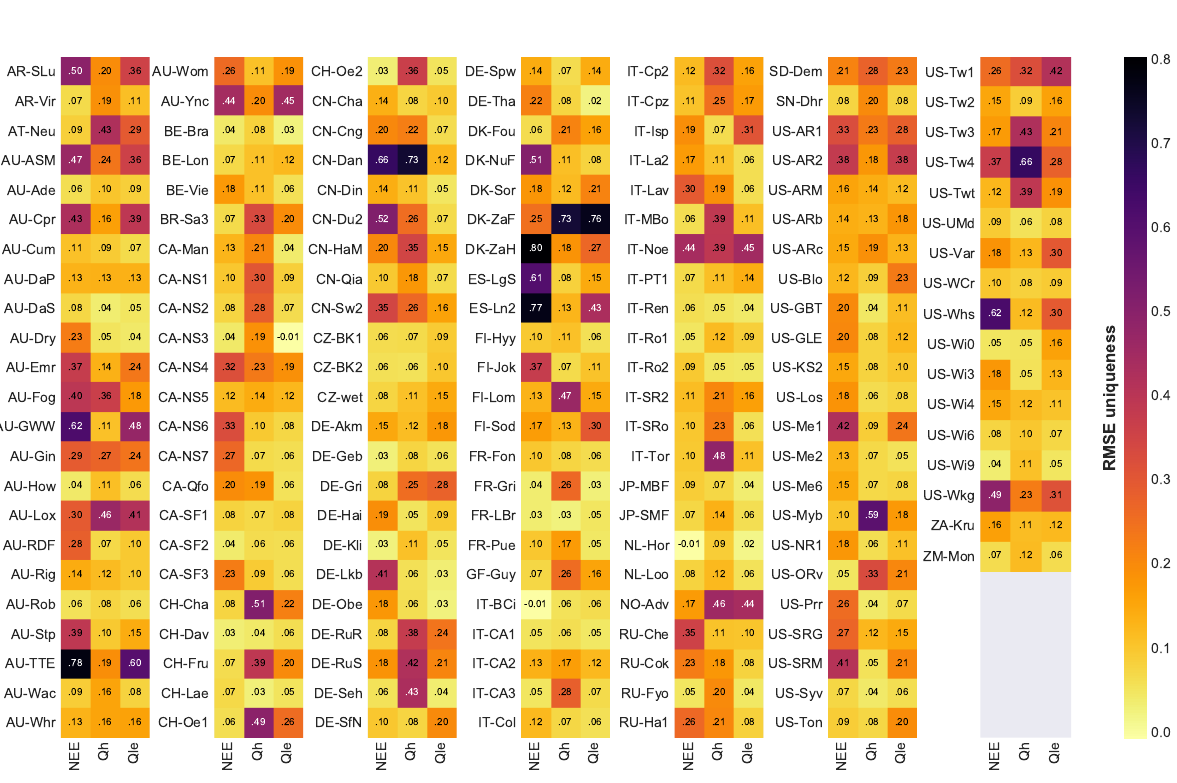
Figure 9. RMSE uniqueness for good QC ratio in flux forcings.